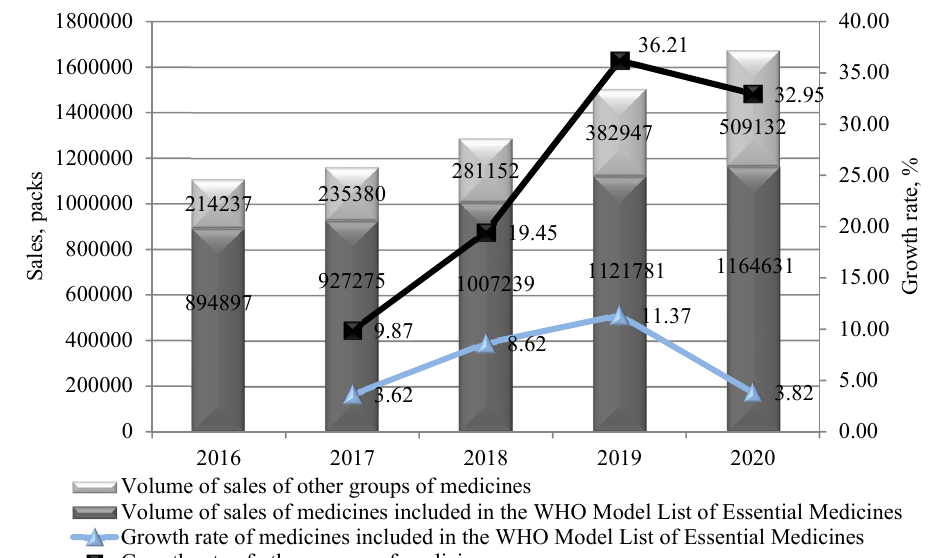
Fig. 11. Dynamics of indicators of sales volumes in physical terms of drugs included in the WHO Model List of Essential Medicines and other medicines for the pharmaceutical market of Belarus